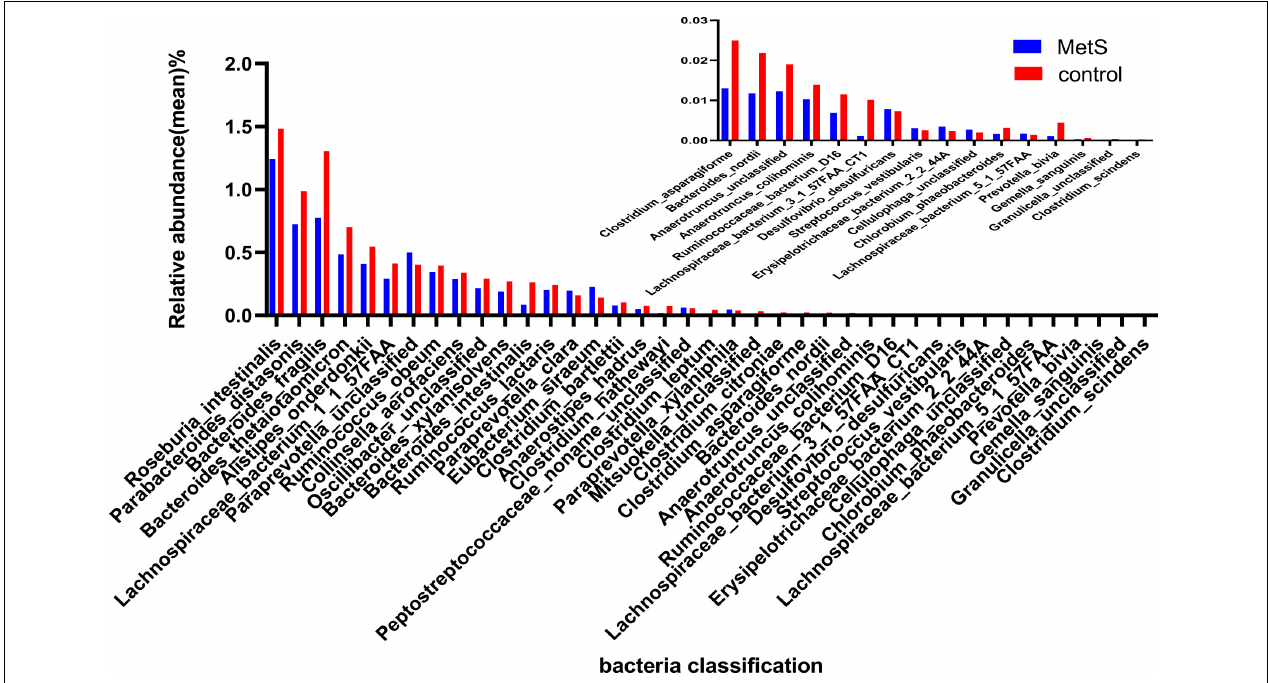
FIGURE 3 | The relative abundance of bacterial species between the MetS and control groups. We used Wilcoxon tests to analyze the relative abundance of bacterial species and found significant differences in 39 species, with 31 enriched in the control group and 8 enriched in the MetS group. p < 0.05.